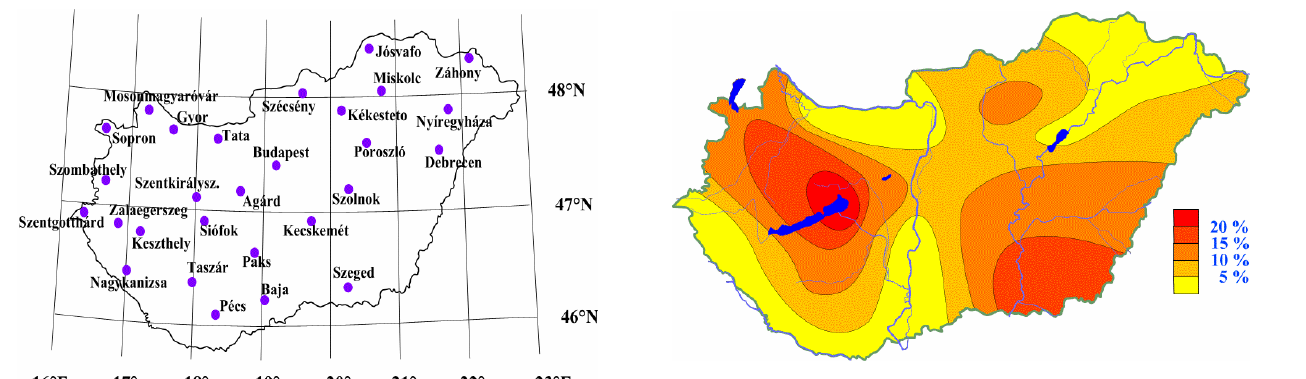
Figure 1. Figure 1. Geographical locations of meteorological stations in- volved in the analysis.